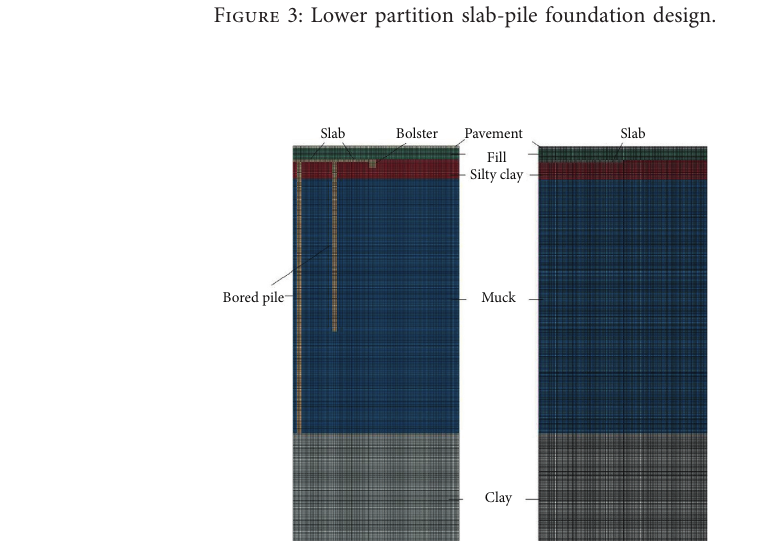
Figure 3: Lower partition slab-pile foundation